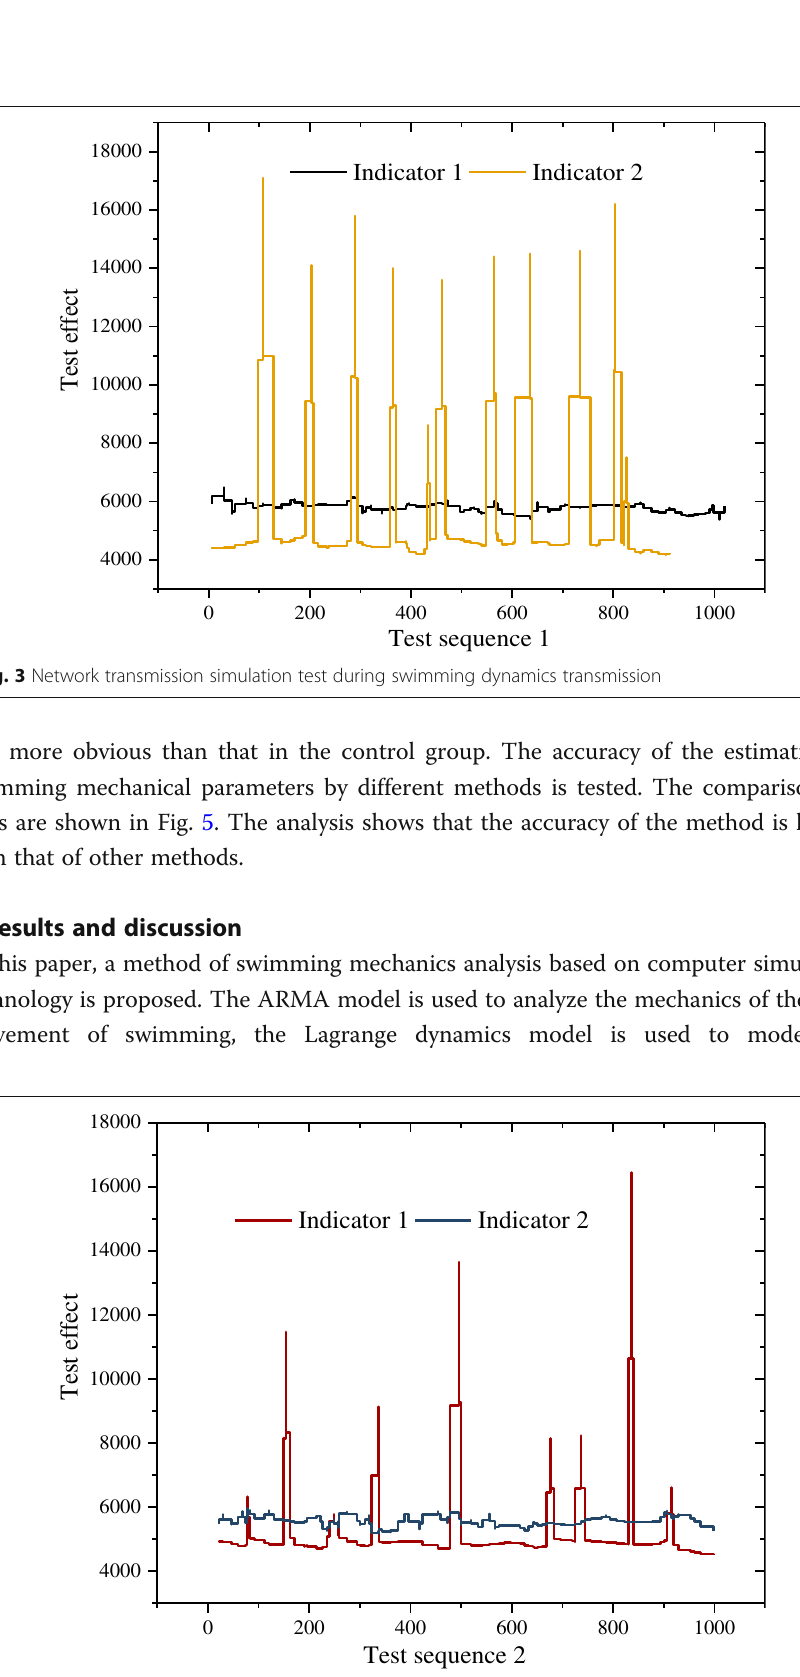
Fig. 4 Network packet loss rate test during swimming dynamics